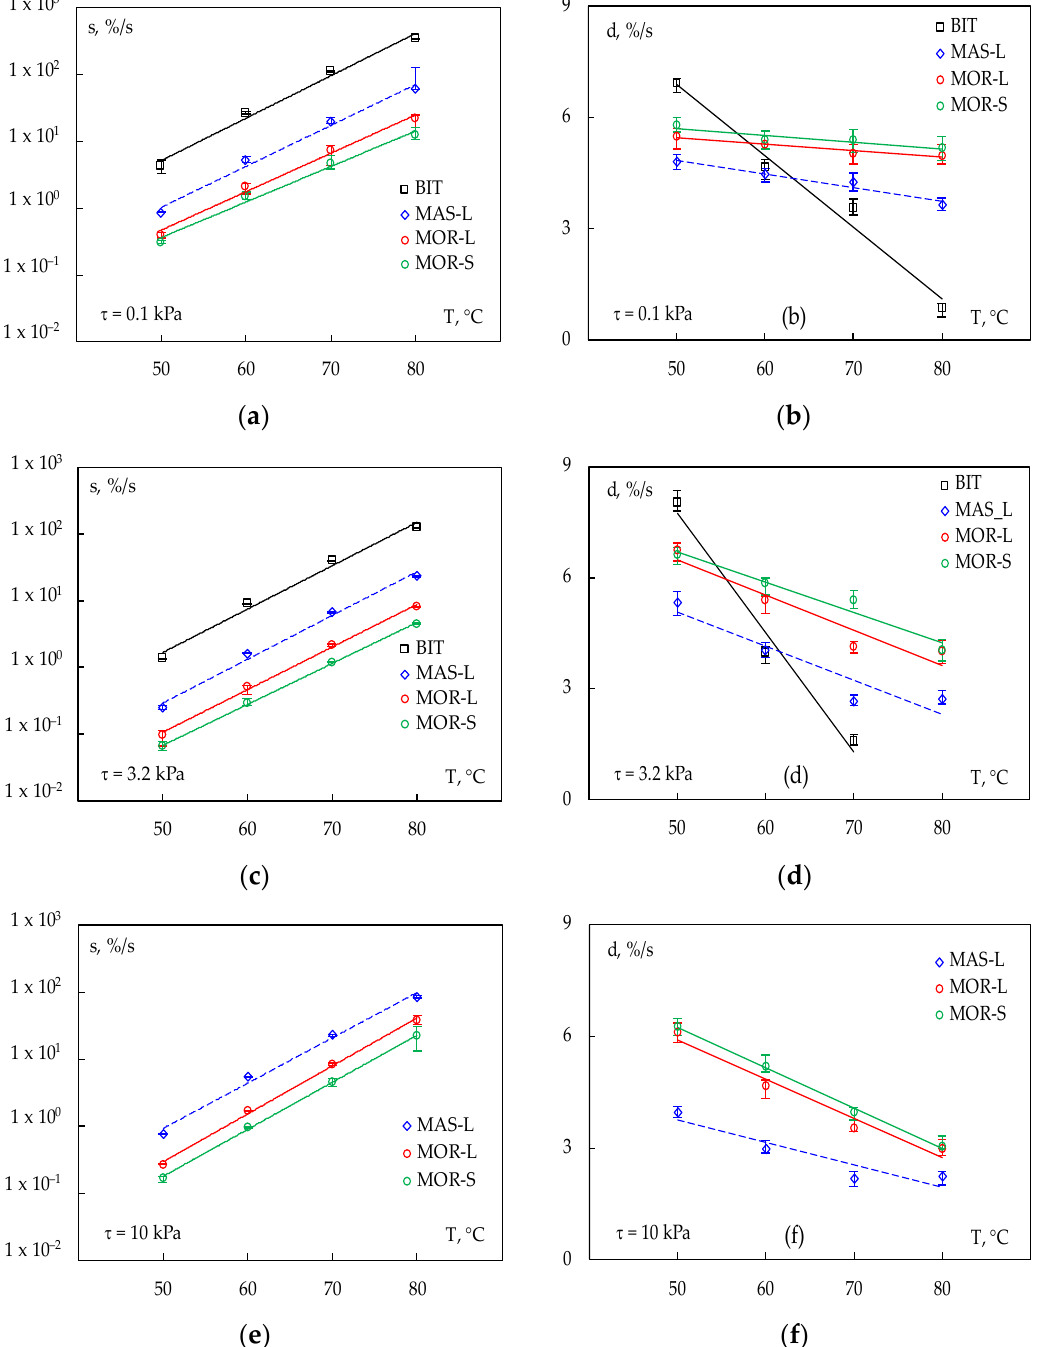
Figure 8. Physical parameters describing creep-recovery strain evolution: s ( a ) and d ( b ) at 0.1 kPa; s ( c ) and d ( d ) at 3.2 kPa; s ( e ) and d ( f ) at 10 kPa.